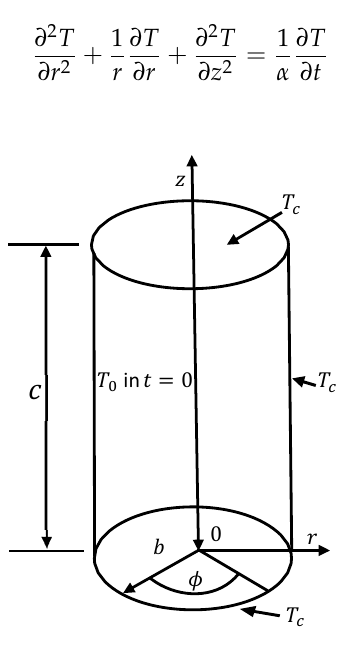
Figure 1. The cylinder with a radius and height specified, under certain initial and boundary conditions in the cylindrical coordinate